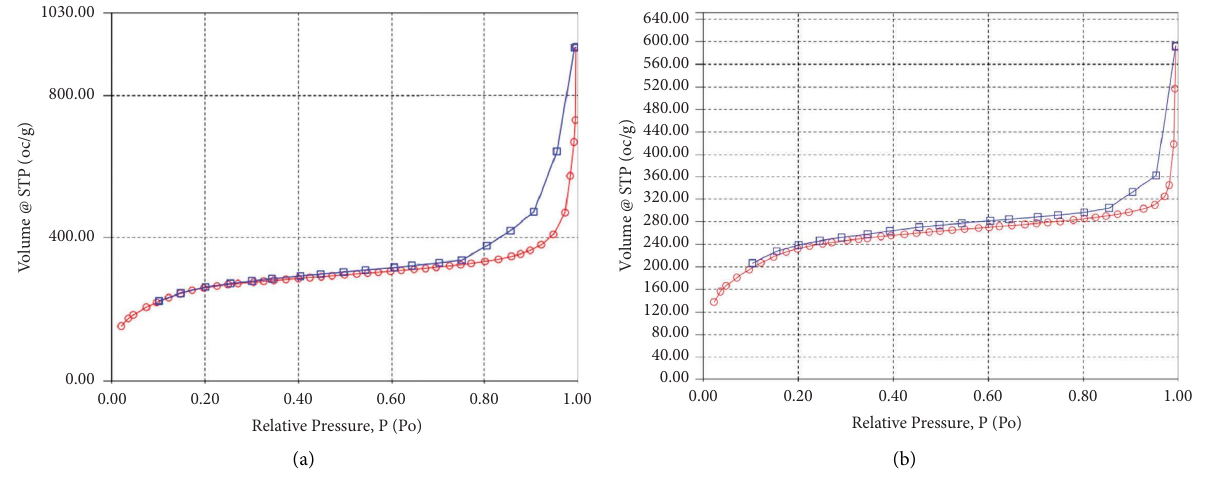
Figure 5: N 2 adsorption and desorption isotherm curve: (a) MIPMS-2; (b) NIPMS-2. Table 6: Surface area and total pore volume of MIPMS-2 and NIPMS-2. Sorbent